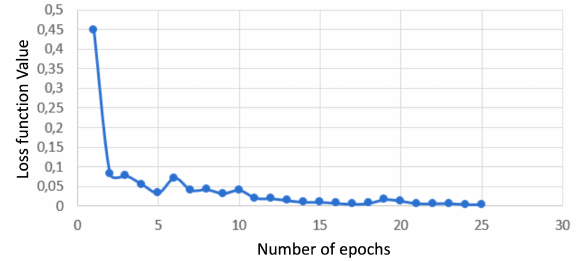
Figure 7 : evolution of the value of the Loss function depending on the number of epochs